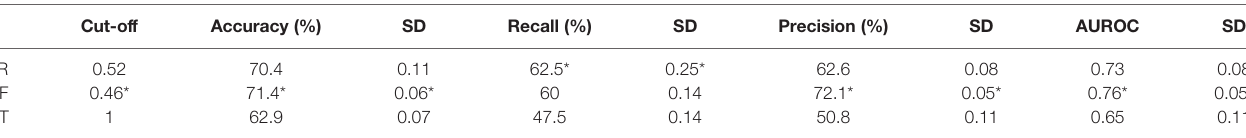
TABLE 2 | Performance of the ML algorithms. Cut-off Accuracy